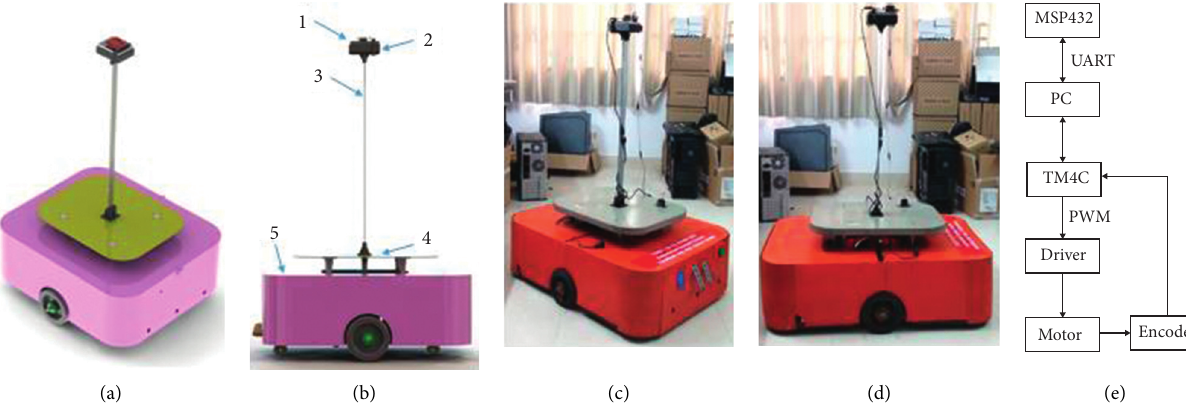
Figure 15: Experimental setup test: (a) virtual 3D view, (b) virtual side view: board sensor 1 , m the vehicle 4 , and practical automated guided vehicle 5 , (c) real 3D view, (d) real side view and (e) flowchart of the data transmission (see in